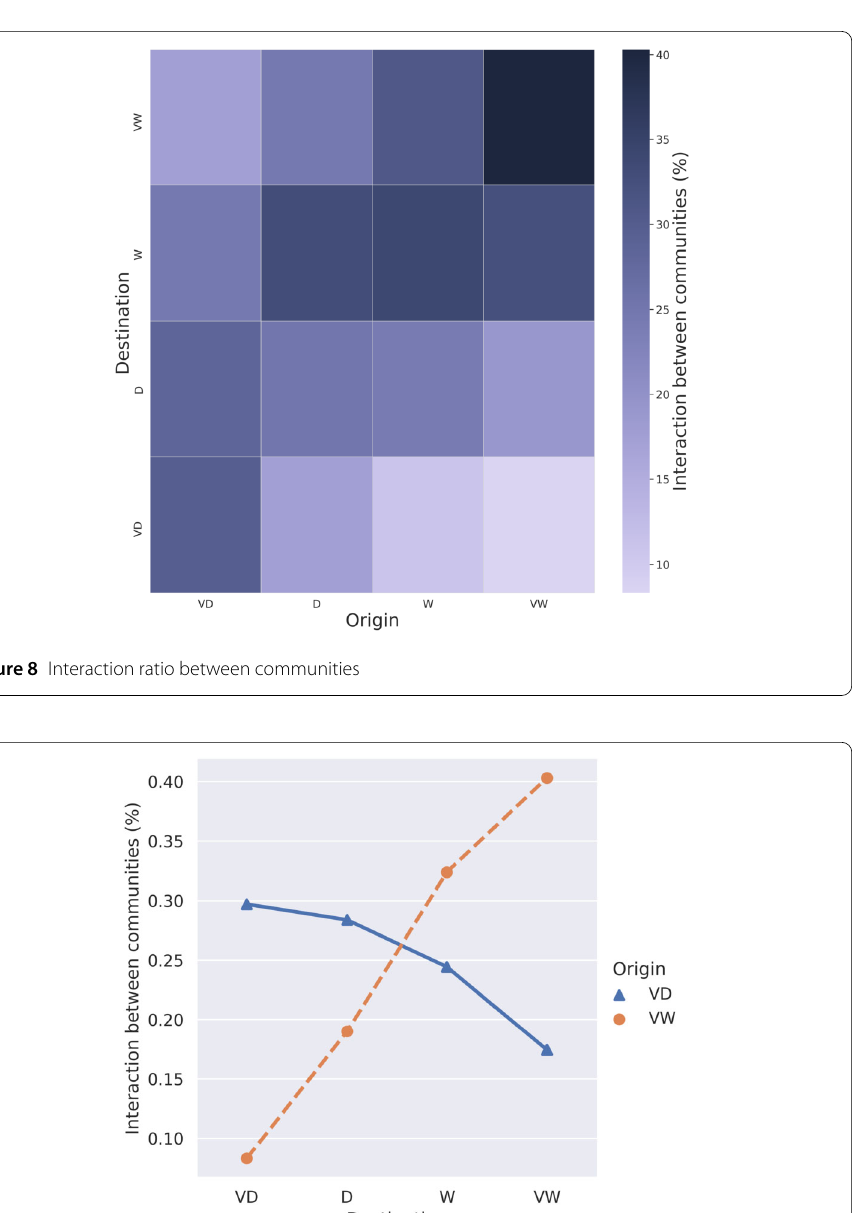
high; both belong to the VW class. For both the ratio of interaction with markers of the same social level is very high (32% and 37%). The interaction ratio decreases dramatically when we consider the movements between these areas and the poorer areas of the city. In this case the interaction ratio falls to 10% and 7% respectively. A similar behavior was observed when we picked two markers with a low value of education index, one from the north of the city and one in the west. Also in this case, the interaction ratio with markers of the same social level is high (31% and 27%, respectively). While, the interaction ratio with markers for the most well-off areas, the ratio decreases to 14% for the first marker and 16% for the